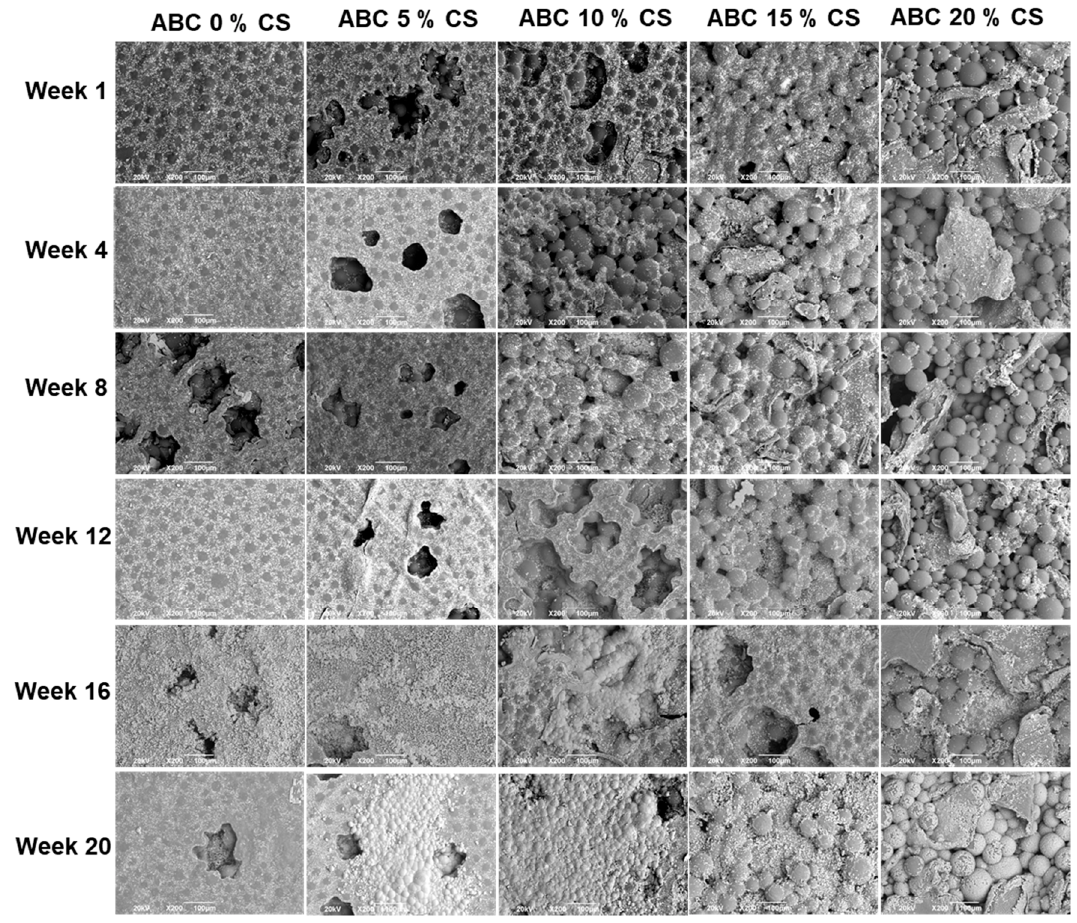
Figure 7. SEM micrographs of the surfaces of ABCs loaded with CS after different times of soaking in simulated body fluid (SFB) (200×).